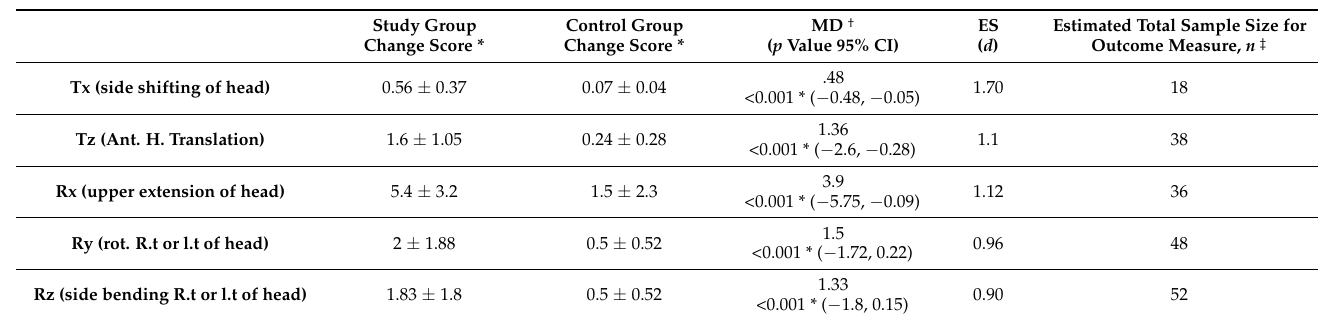
H, head. rot., rotation. * Values are mean ± SD. † Values in parentheses are 95% confidence interval. ‡ Estimated sample size determined using Student t test sample size calculation, without adjusting for anticipated dropouts and losses to follow-up ( α = 0.01, β = 0.80). Sig; 0.01. ES ( d ), Effect size (Cohen’s d ). Table 8. Correlations (Pearson’s r ) were used to examine the relationships between the 3D postural parameters and all measured outcomes for the entire sample. * Indicates a statistically significant difference at p <